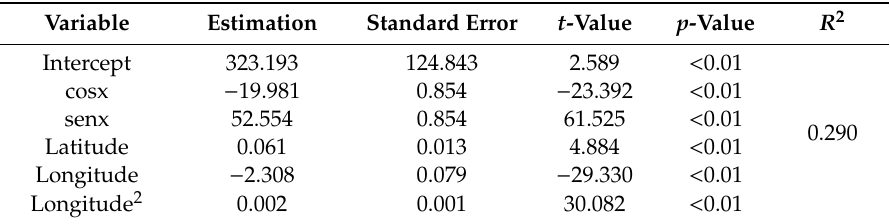
Table 2. Estimation of the parameters of the model described in the Equation (2) of the rainfall in the region analyzed from 1994 to 2014.